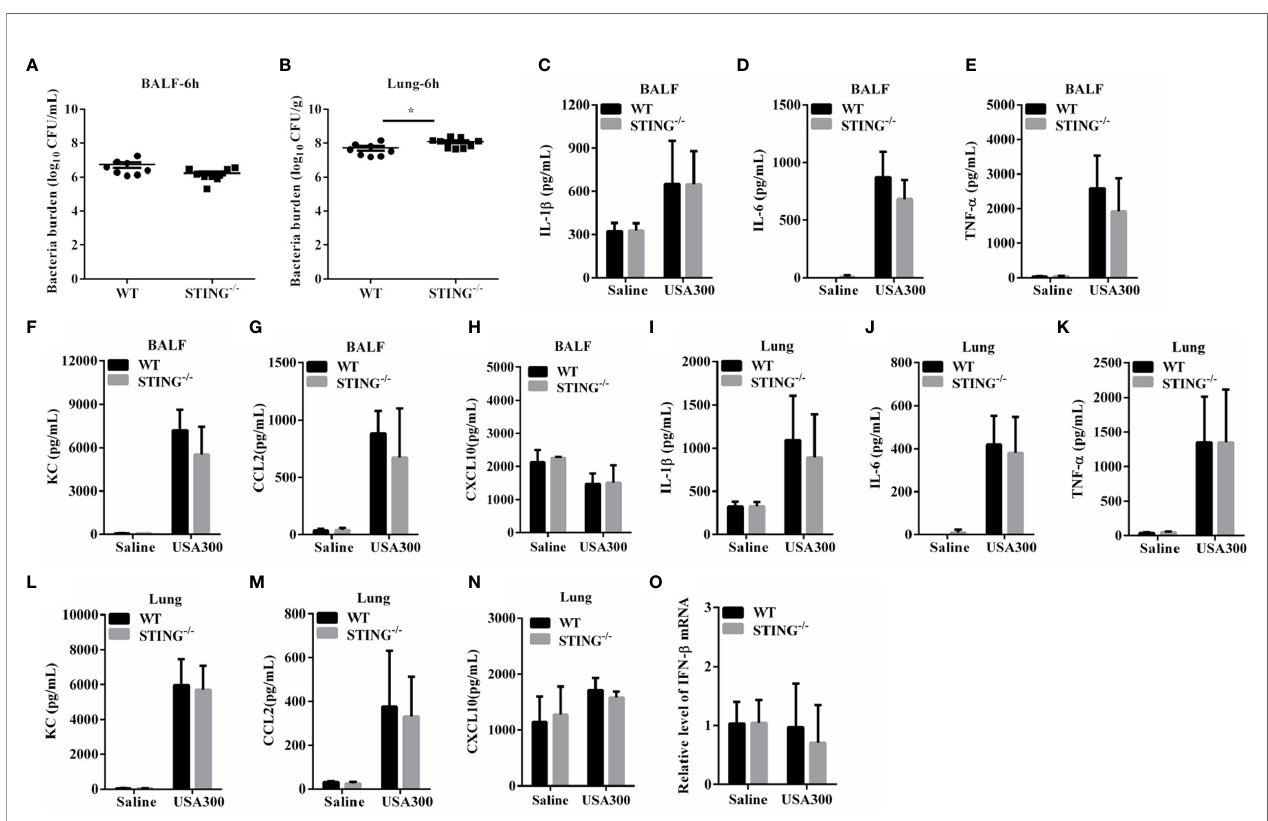
FIGURE 3 | STING promotes early lung bacterial clearance without excessive in fl ammation. WT and STING -/- mice (N = 8-9/group) were infected intranasally with S.aureus (1 × 10 8 CFU/mouse) and then were euthanized at 6 hpi to quantitate the bacterial burden in (A) BALF and (B) lung. BALF and lung homogenates were detected for concentrations of indicated cytokines and chemokines by ELISA. (C, I) IL-1 b , (D, J) IL-6, (E, K) TNF- a , (F, L) KC, (G, M) CCL2, and (H, N) CXCL10. (O) Lung tissue mRNA was examined for IFN- b by qRT-PCR. All data are shown as mean ± SEM. Student ’ s t-test was performed. Statistical signi fi cance is indicated by *p < 0.05, **p < 0.01, and ***p <